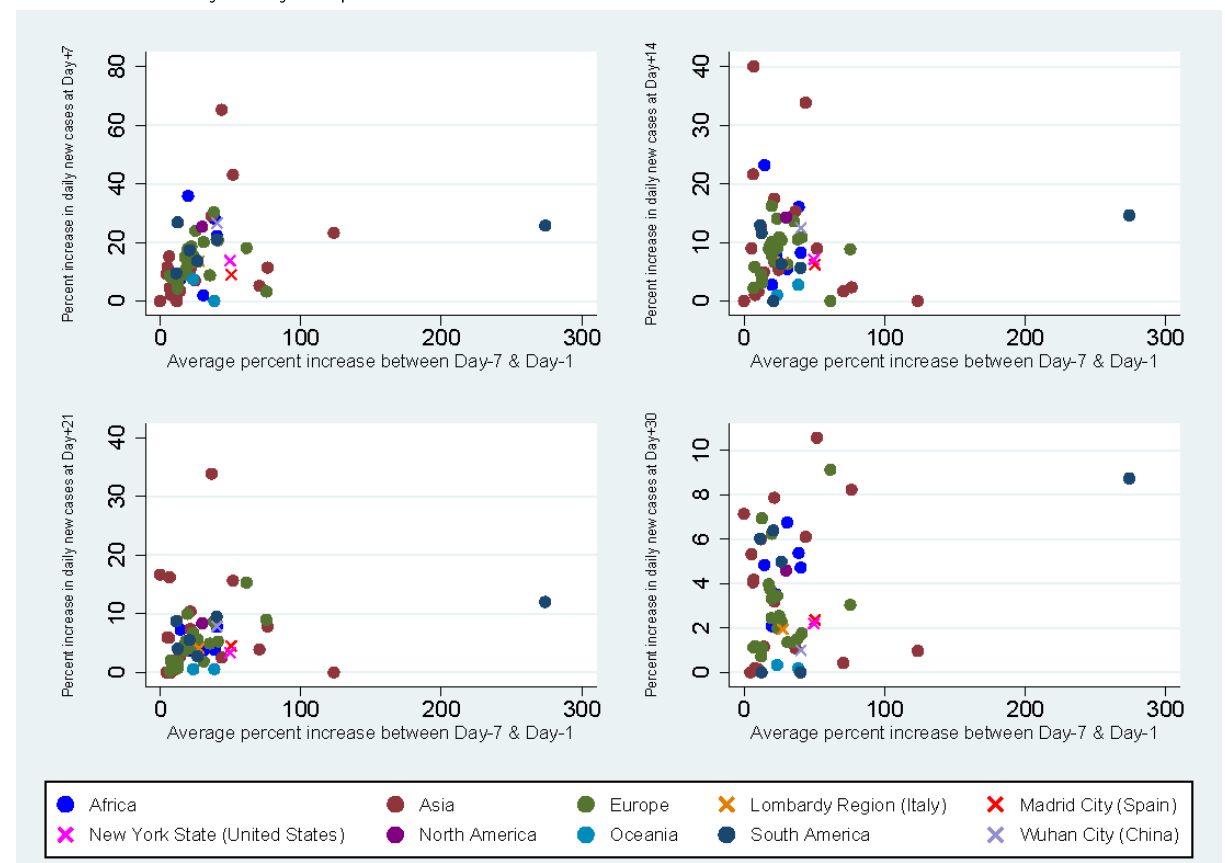
Figure 6. Percent increases in daily new cases at day +7 (A), day +14 (B), day +21 (C) and day +30 (D) against average percent increase in daily new cases before intervention by country and